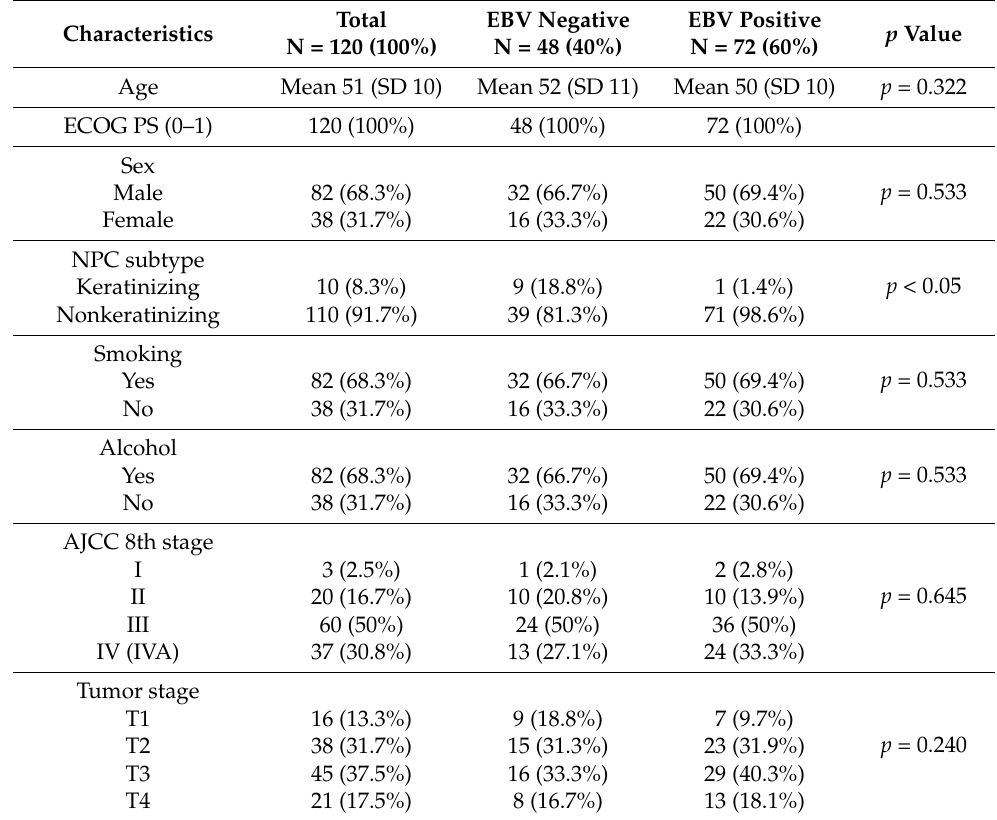
Table 2. Clinicopathological features of NPC patients according to EBV